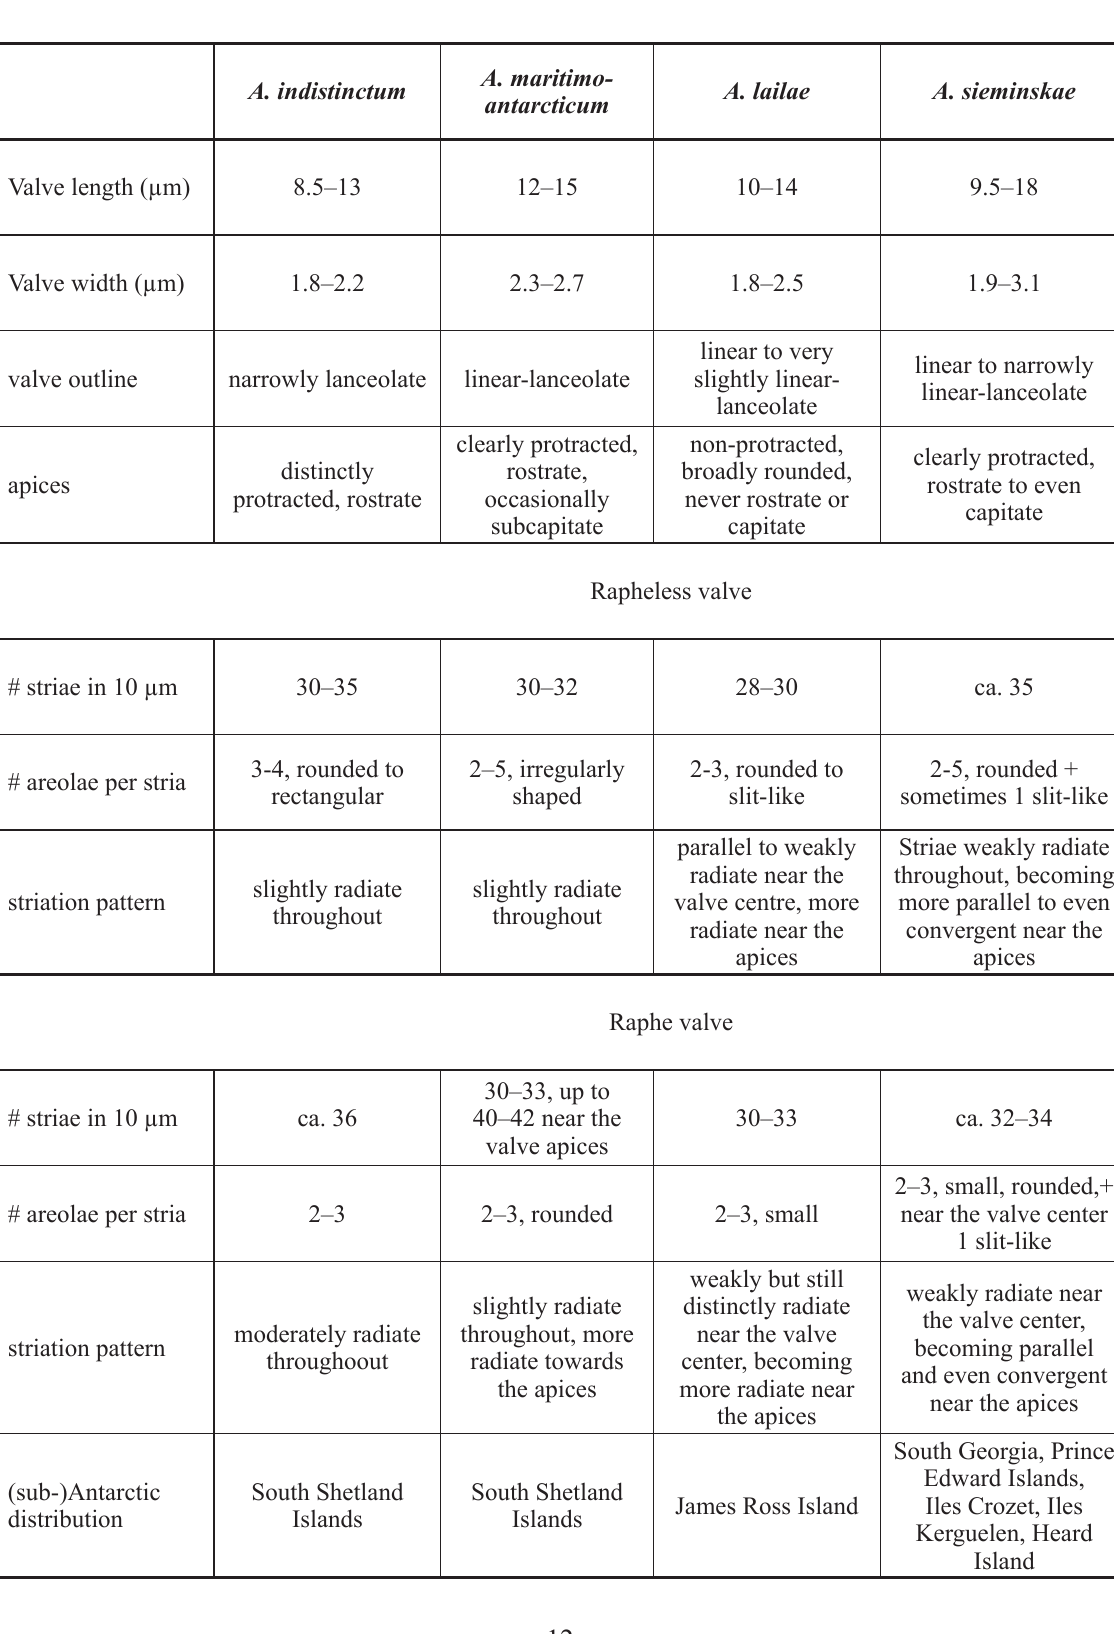
Table 2. Overview of the main morphological features of all four taxa formerly identified as A. minutissimum s.l. reported from the Antarctic